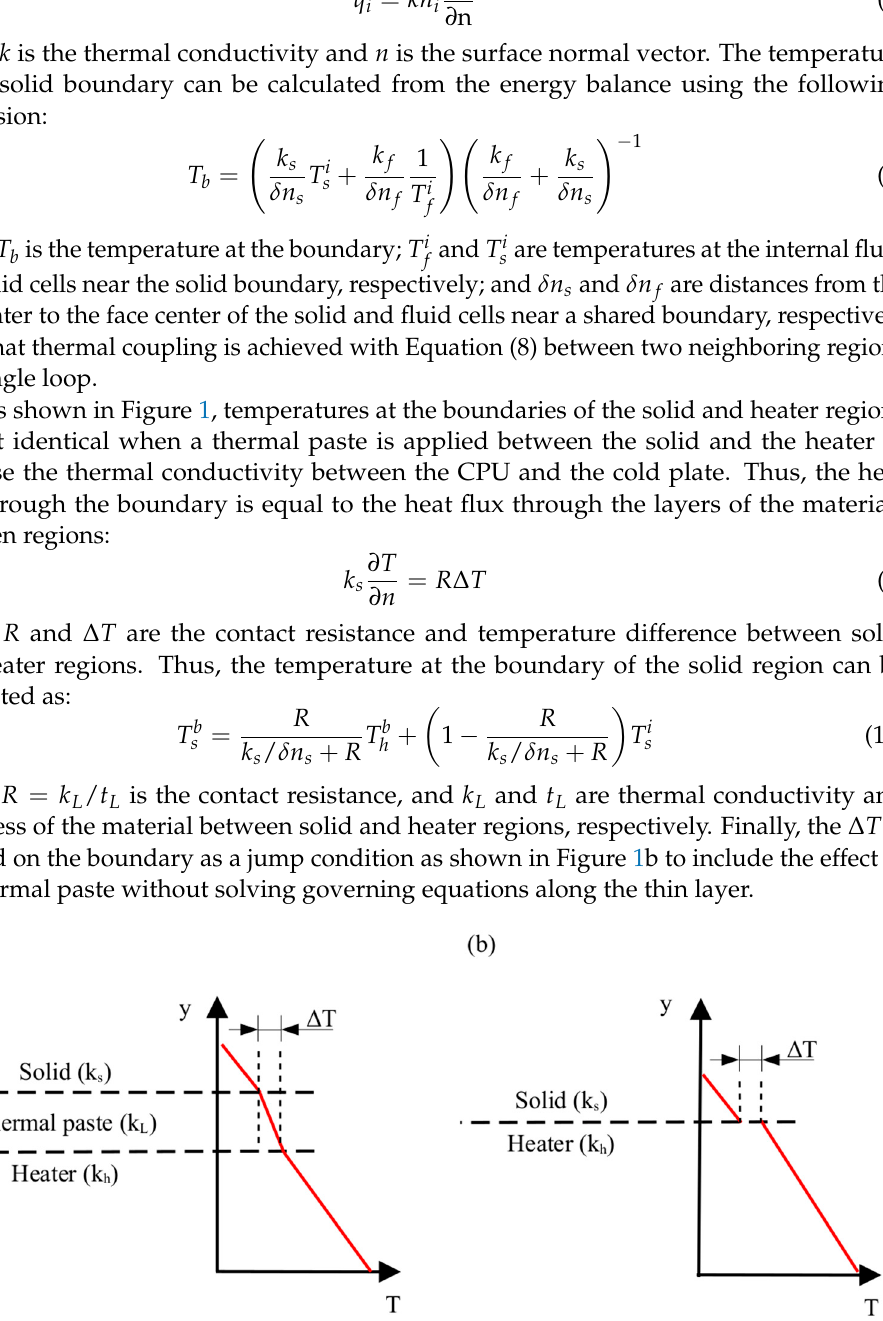
Figure 1. Numerical modeling of the thermal paste: ( a ) physical and ( b ) numerical representations.